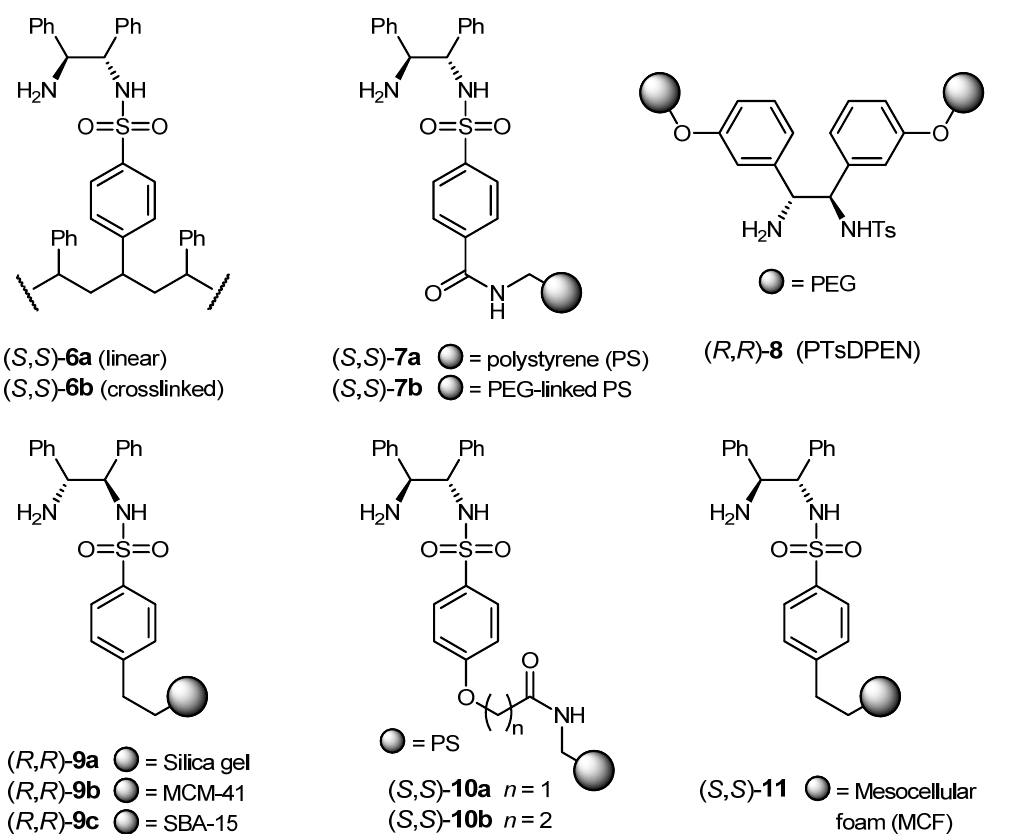
Figure 3. Immobilized TsDPEN-based ligands